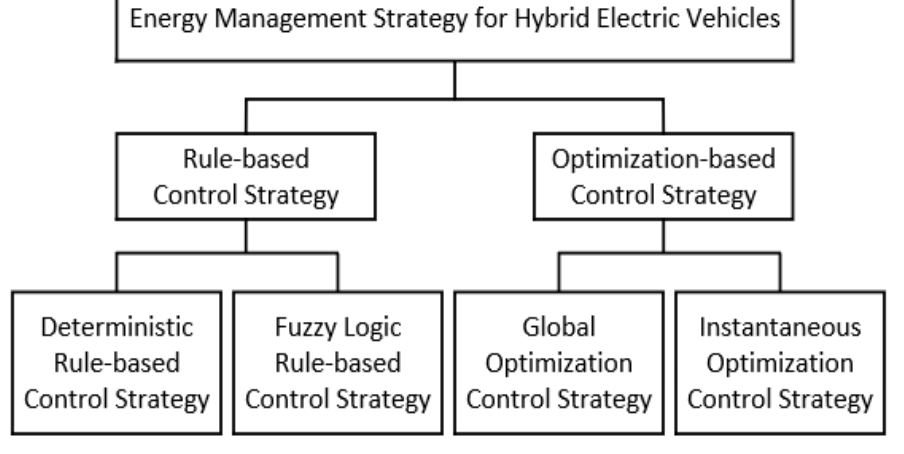
Figure 8. Energy management strategy for HEVs.